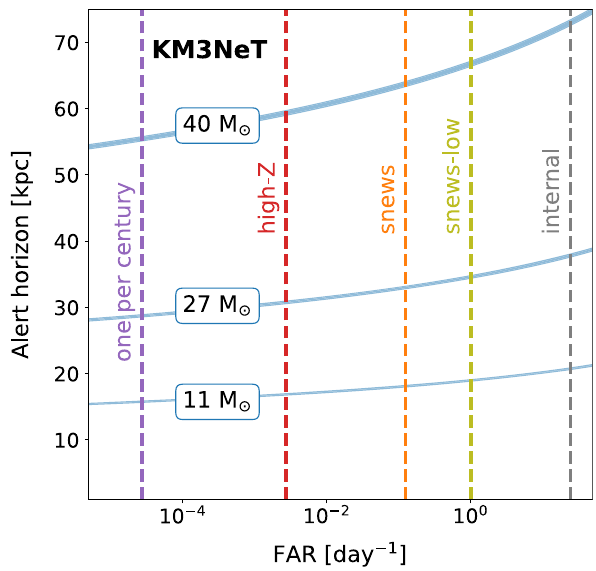
Fig. 7 Maximal source distance (blue band) for which the complete KM3NeT ARCA + ORCA detector will be able to produce an alert for the FAR thresholds corresponding to the qualifiers defined in Sect. 4 plus an additional threshold corresponding to a FAR of one per century (vertical dashed lines). The band width accounts for the variability of the background and signal expectations, assuming the same relative variations of Fig.